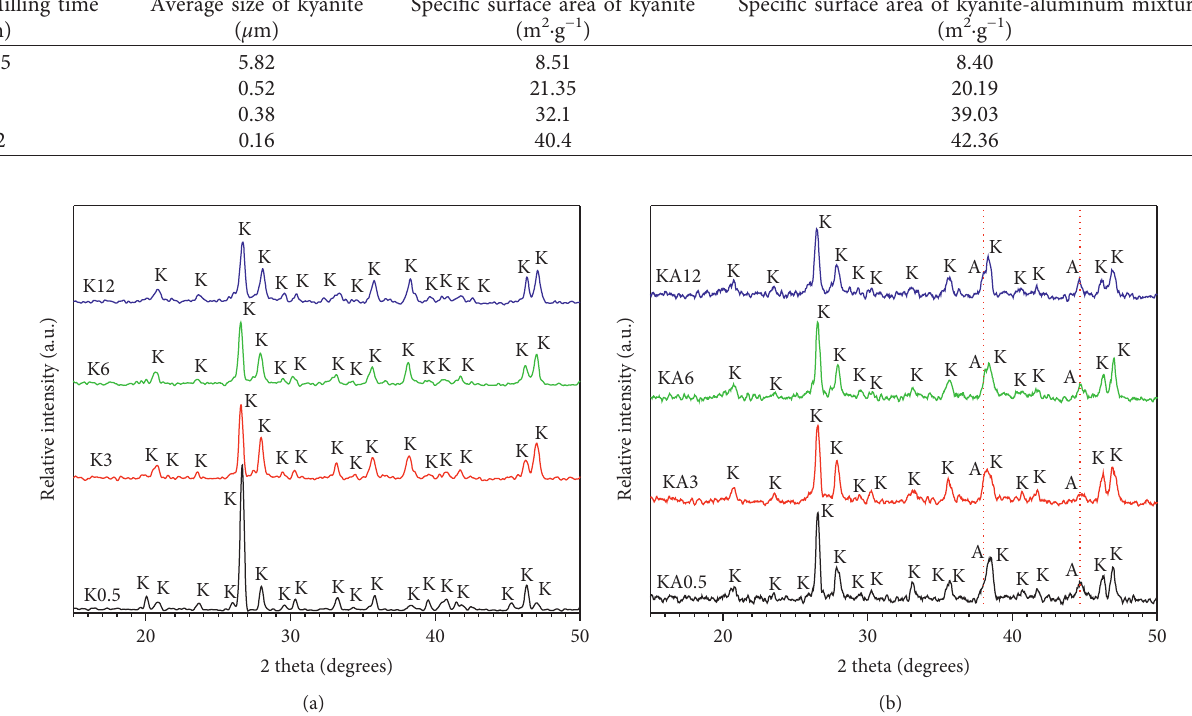
Figure 5: XRD patterns of the raw kyanite (a) and kyanite-aluminum metal mixtures (b) milling at different times. K � kyanite; A �